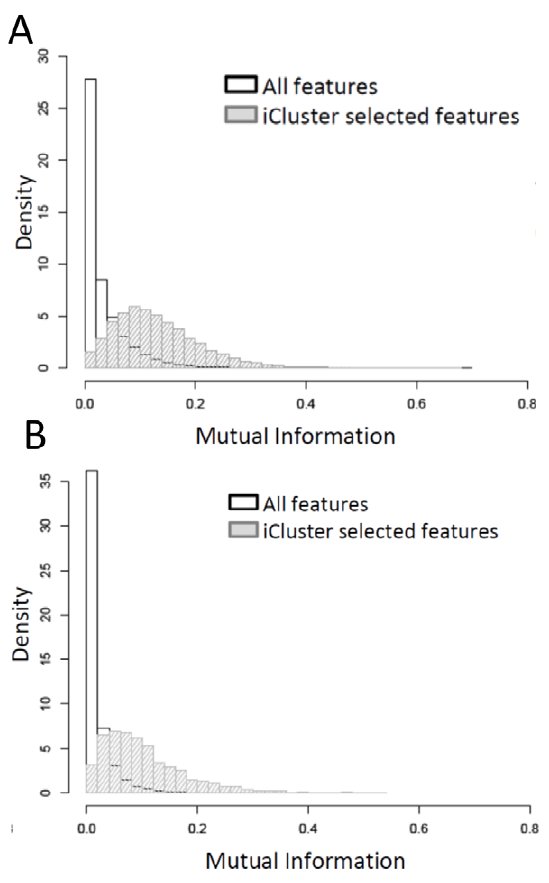
Figure 7. Mutual information.